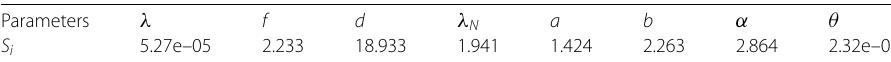
Table 2 The sensitivity values of eight parameters